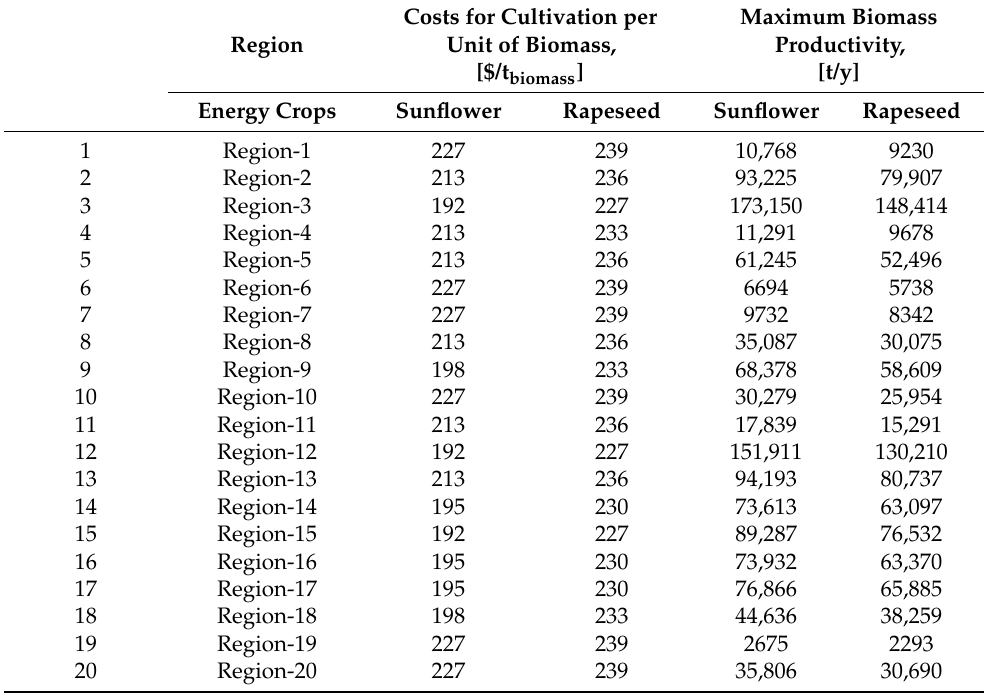
The costs for growing biomass and the maximum amount of biomass that can be produced in the regions of Bulgaria are listed in Table 2. Table 2. Costs for growing biomass and maximum amount of biomass that can be produced in the regions of Bulgaria